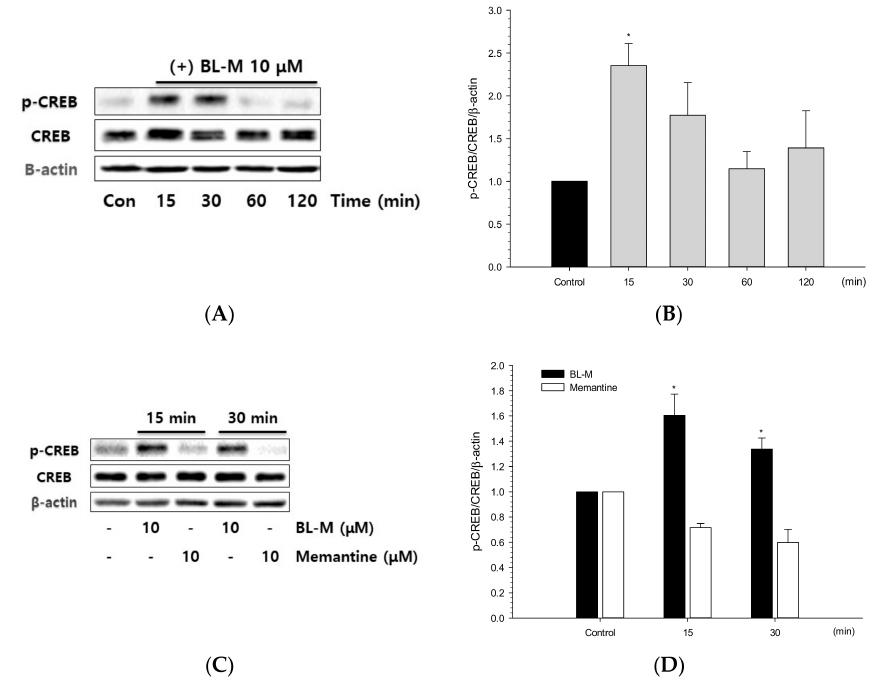
Figure 6. Phosphorylation of CREB by BL-M in primary cultured rat cortical cells. Cells (10–11 days in vitro) were treated with either BL-M alone ( A ) or BL-M or memantine ( C ) for the indicated periods of time, and the cell lysates were analyzed by Western blotting with a primary antibody of anti-phospho-CREB (Ser133). Total CREB and β -actin were used for loading control. The quantitative analyses were expressed as relative changes with respect to the respective control group ( B , D ) (* p < 0.05 vs. control). Each data represents the mean ± S.E.M. from at least three independent